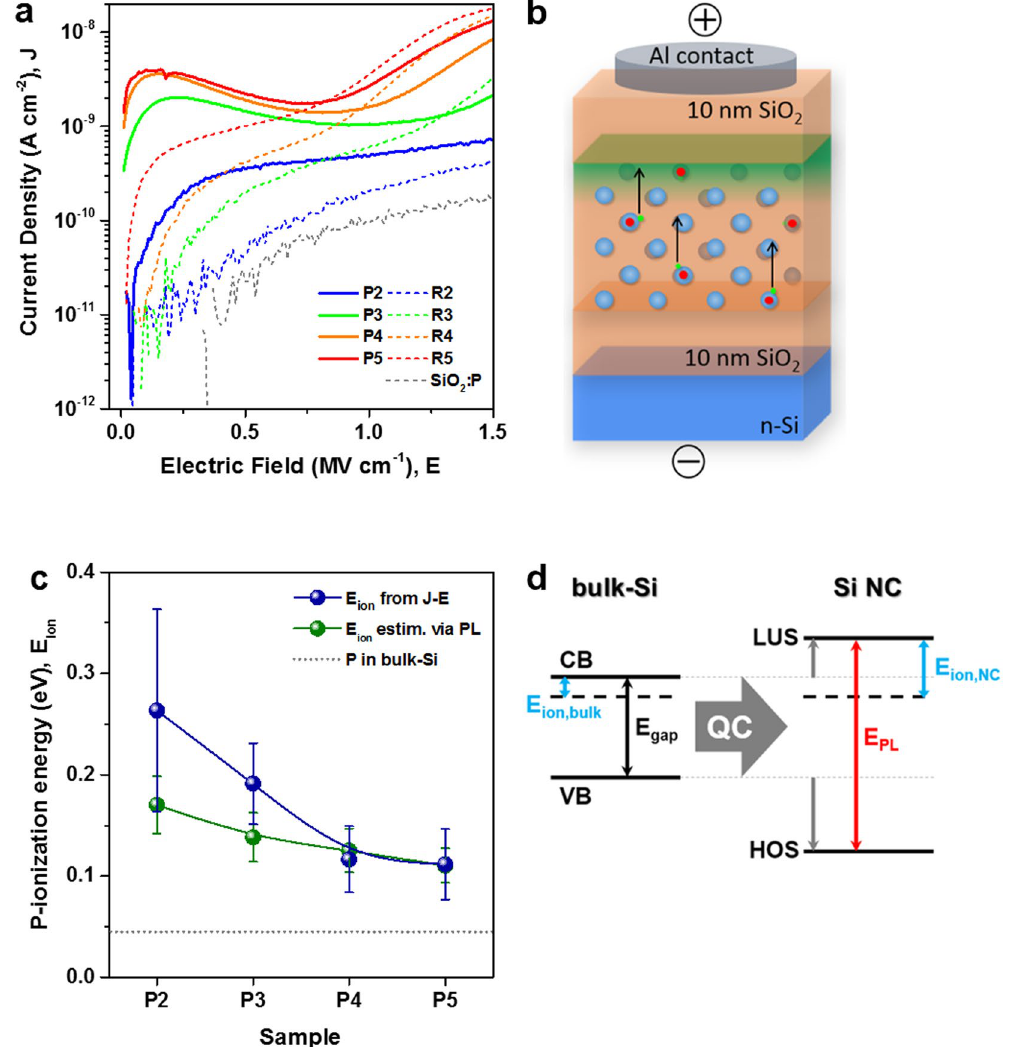
Figure 3. Current-voltage measurements (I-V) and derived ionization energies of P-atoms in Si NCs. ( a ) Current density vs. electric field of sample set E (P: Si NCs incorporating on average ~1 P-atom per NC, R: undoped reference samples). At low E-fields the P-samples (solid lines) clearly exhibit higher displacement current densities than the respective reference sample (dashed lines). ( b ) The schematic shows the sample structure (large blue spheres: Si NCs, red points: P-atoms in Si NCs, small green points: donor electrons localized at P-atoms in thermal equilibrium): Since charge injection from gate or substrate is blocked at low fields, only transient displacement currents caused by P-donors are measured, which accumulate under the gate electrode (shown in green). ( c ) Ionization energies of P-donors derived from I-V measurements according to Equation (2) with the mean size of the P-incorporation fraction of NCs (cf. Fig. 2c) as d NC (blue); and P-ionization energies estimated via the PL-peak energy (green). Both methods yield similarly high P-ionization energies compared to P in bulk-Si (45 meV; grey dotted line). The values increasingly deviate from each other towards smaller NCs but are still within the error bars, which are based on the standard deviations of the NC- size and the uncertainties of the J-peak or respectively the PL peak width. ( d ) Schematic for the estimation of E ion via PL, assuming a Si NC bandgap energy equal to the PL peak energy and a QC-induced LUS-to-HOS shift ratio of 1:2 37